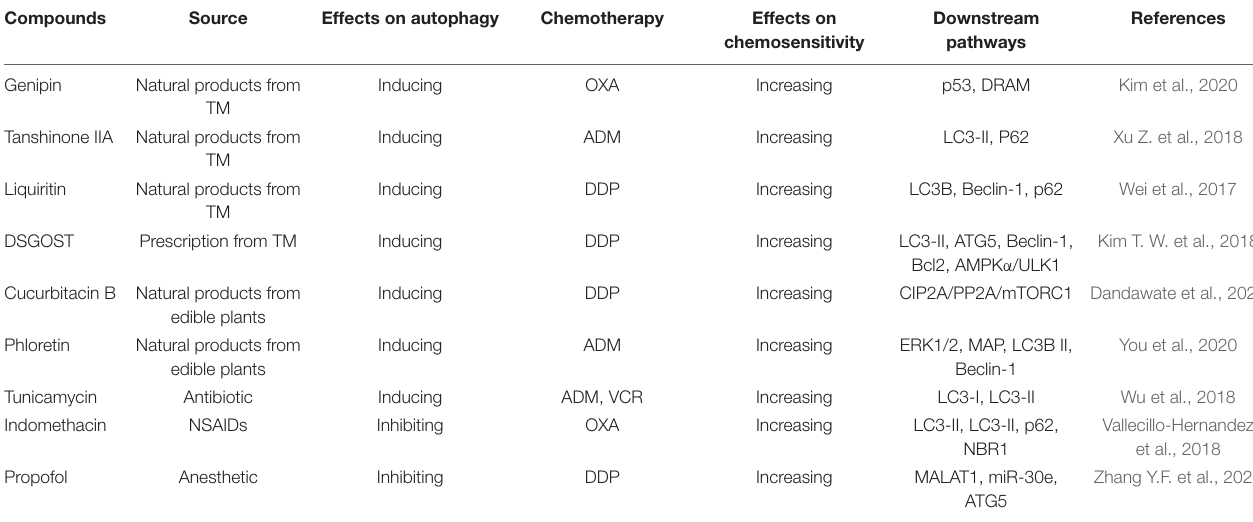
TABLE 3 | Modulatory effects of autophagy inhibitor and activators on gastric cancer chemoresistance.